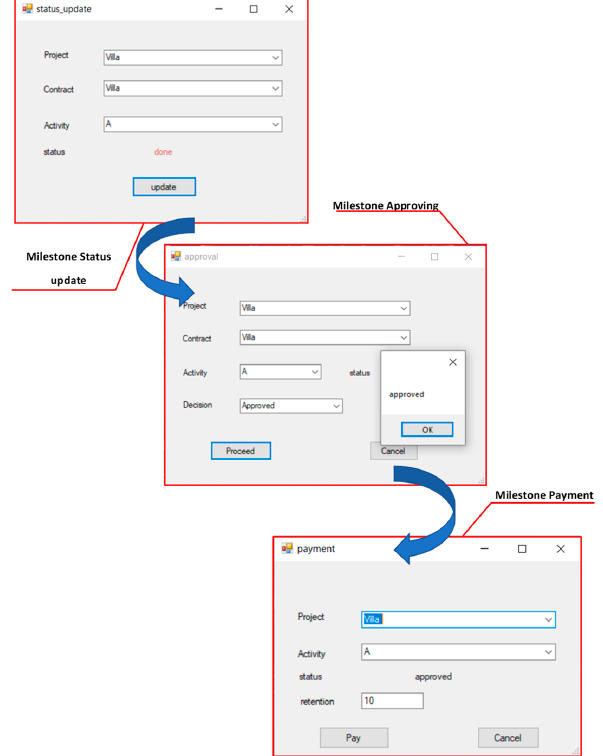
Figure 8. The three scenarios of the hypothetical case study.